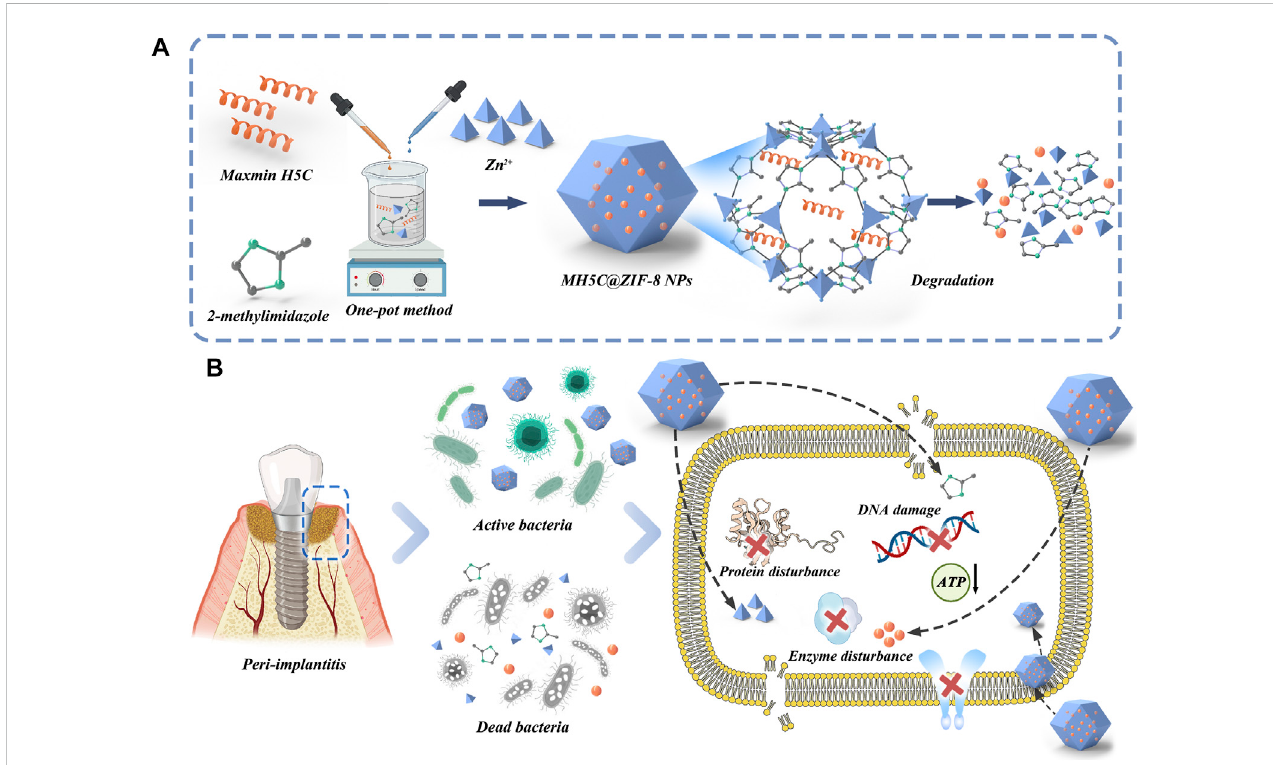
FIGURE 1 (A) Schematic illustration of the fabrication of MH5C@ZIF-8 NPs and degradation route after entering bacteria. (B) Potential antimicrobial mechanisms involved in this chemical decontamination